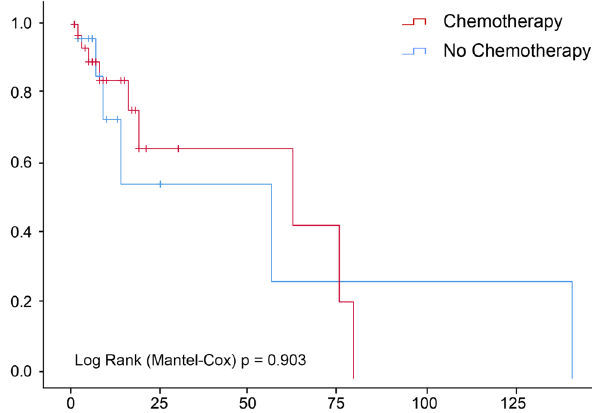
Figure 2: Chemotherapy does not impact survival of patients with hepatoid adenocarcinoma of the lung.